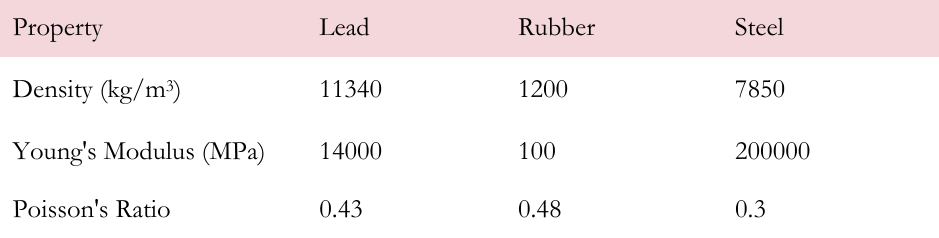
Table 1: Material